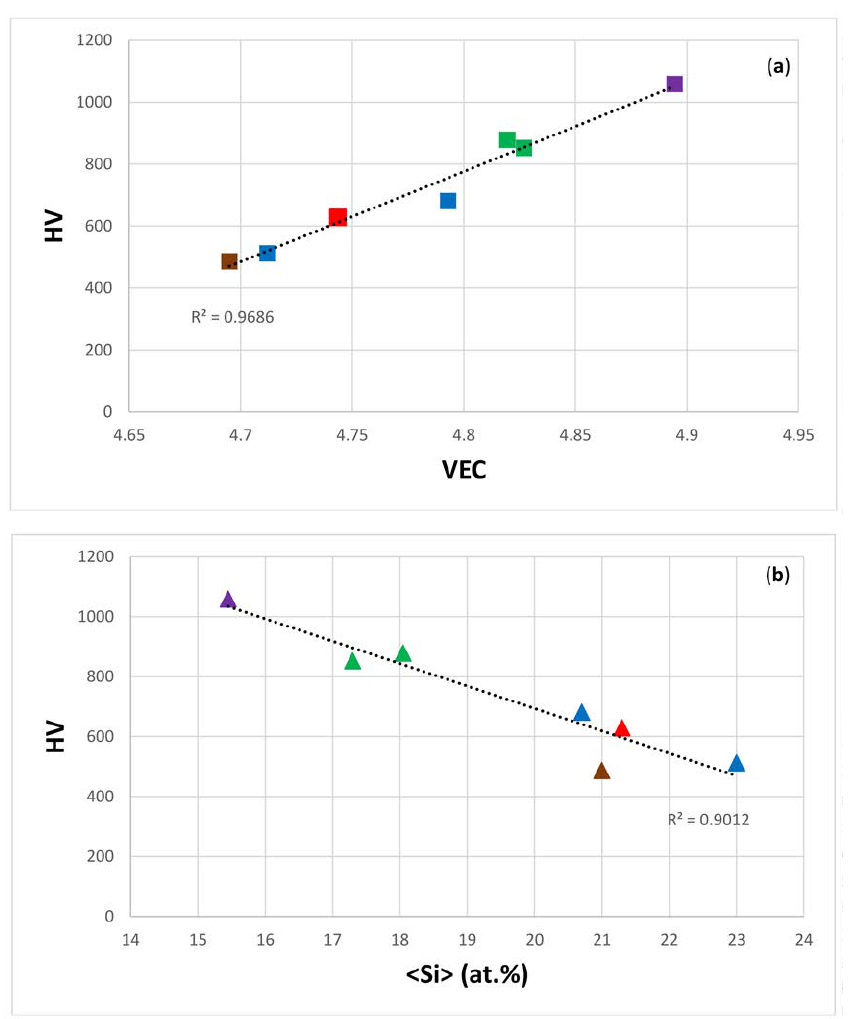
Figure 12. Average Vickers hardness of eutectics versus ( a ) VEC and ( b ) <Si> of eutectics. In both ( a , b ), data for the eutectics with Sn is shown in blue, data for the eutectics with Al is shown in brown, data for the eutectics with Al and Ge is shown in red, data for the eutectics with Ge is shown in green, and data for the eutectics with Cr and Ge is shown in